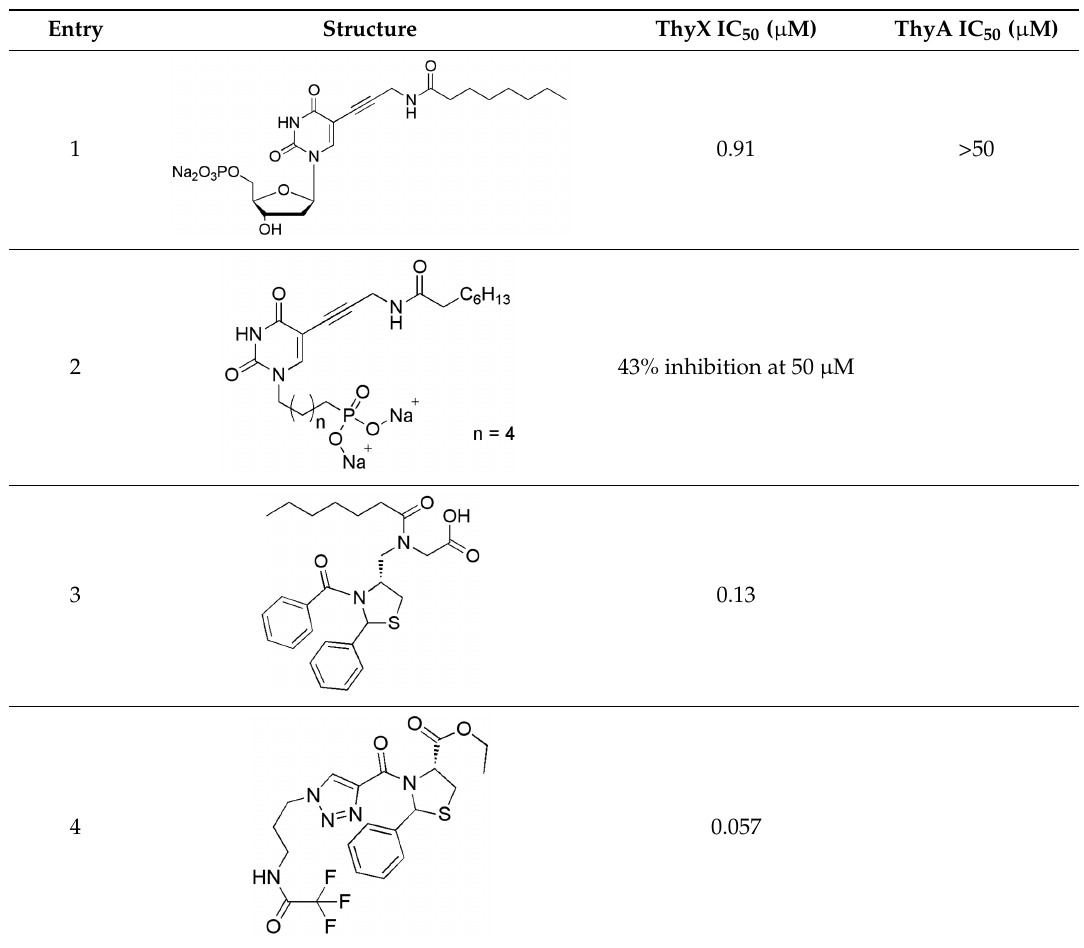
Table 2. Current inhibitors and their IC 50 against FDTS and TSase [28,29,31].